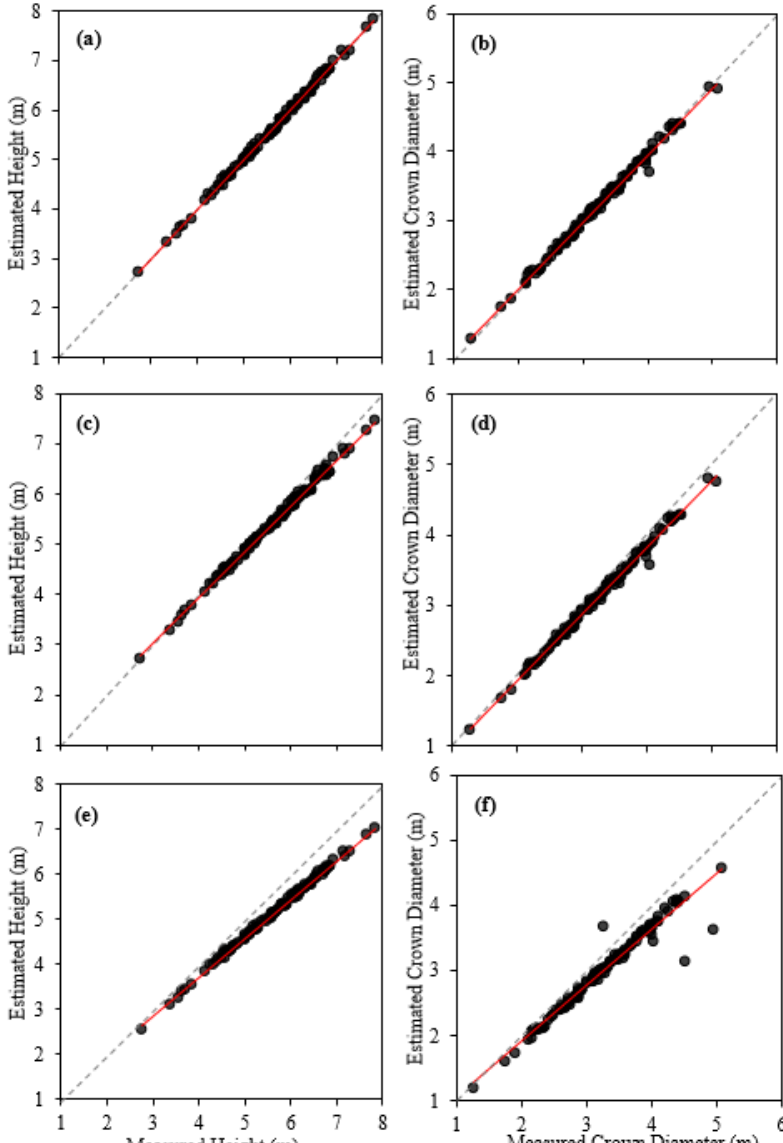
Figure 4. The relationship between the measured and estimated tree height at various flight altitudes: ( a ) 25 m, ( c ) 50 m, ( e ) 100 m, and measured and estimated crown diameter at various flight altitudes: ( b ) 25 m, ( d ) 50 m, ( f ) 100 m. The 1:1 line is shown as a grey dashed line in all panels. Table 4. The results of the fitted linear regression model.